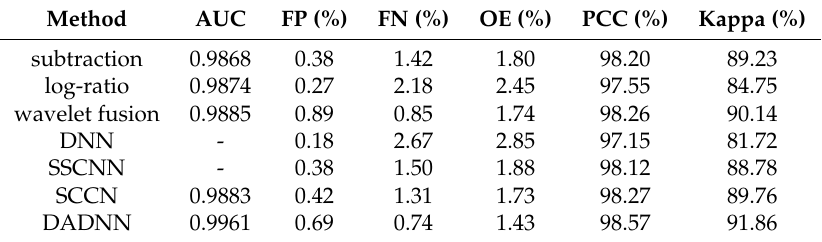
Figure 16. Change detection results obtained by different methods in the Mexico data set: ( a ) subtraction, ( b ) log-ratio, ( c ) wavelet fusion, ( d ) DNN, ( e ) SSCNN, ( f ) SCCN, ( g ) DADNN, and ( h ) ground truth. Table 2. Value of evaluation criteria of the Mexico data